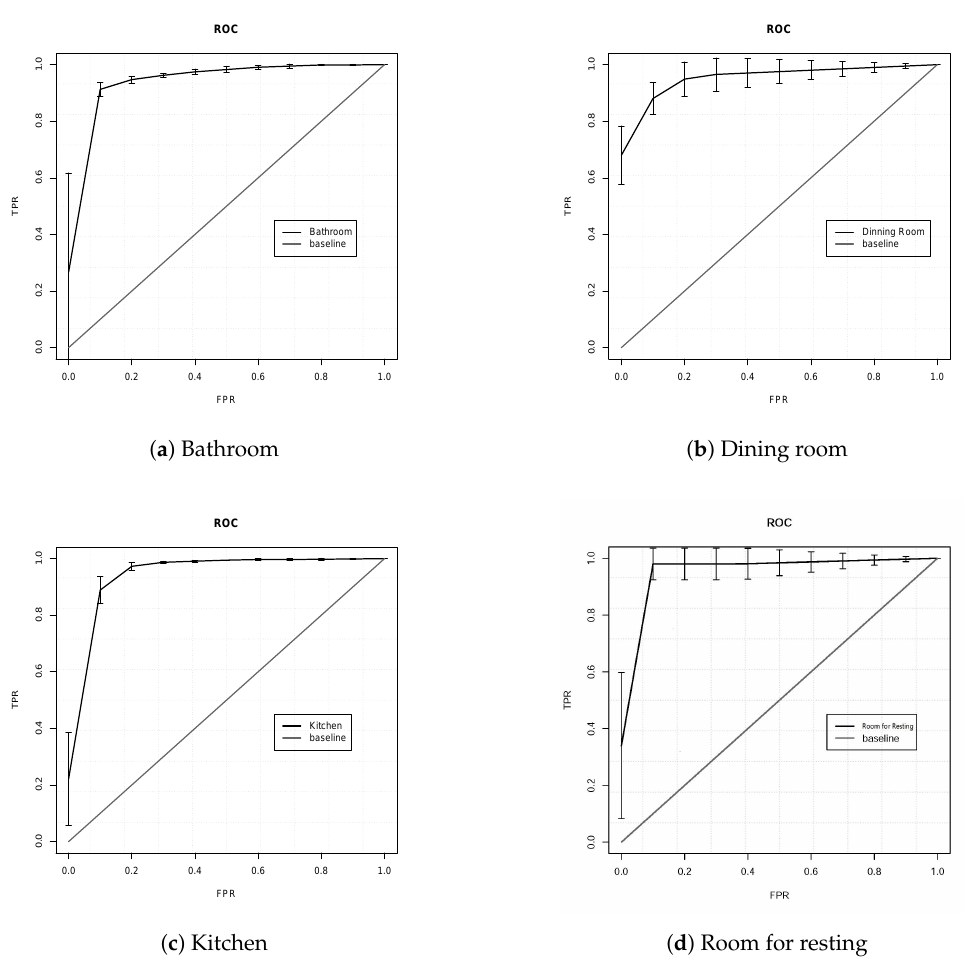
Figure 5. Receiver operating characteristic (ROC) curves for each